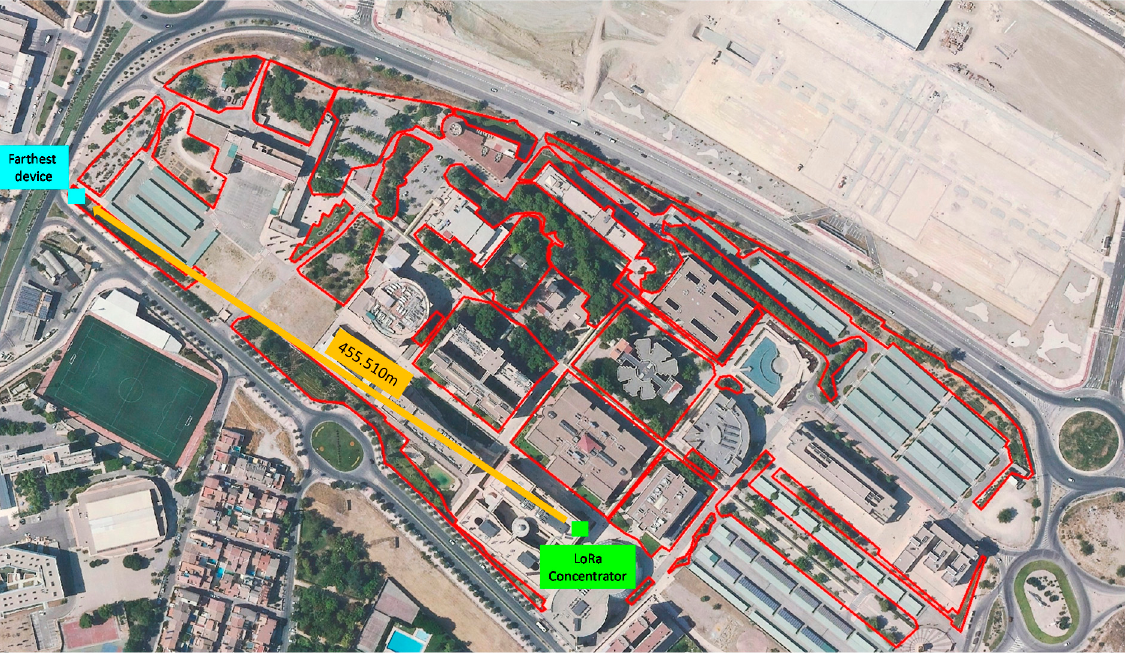
Figure 19. Distribution of irrigation zones on the campus.